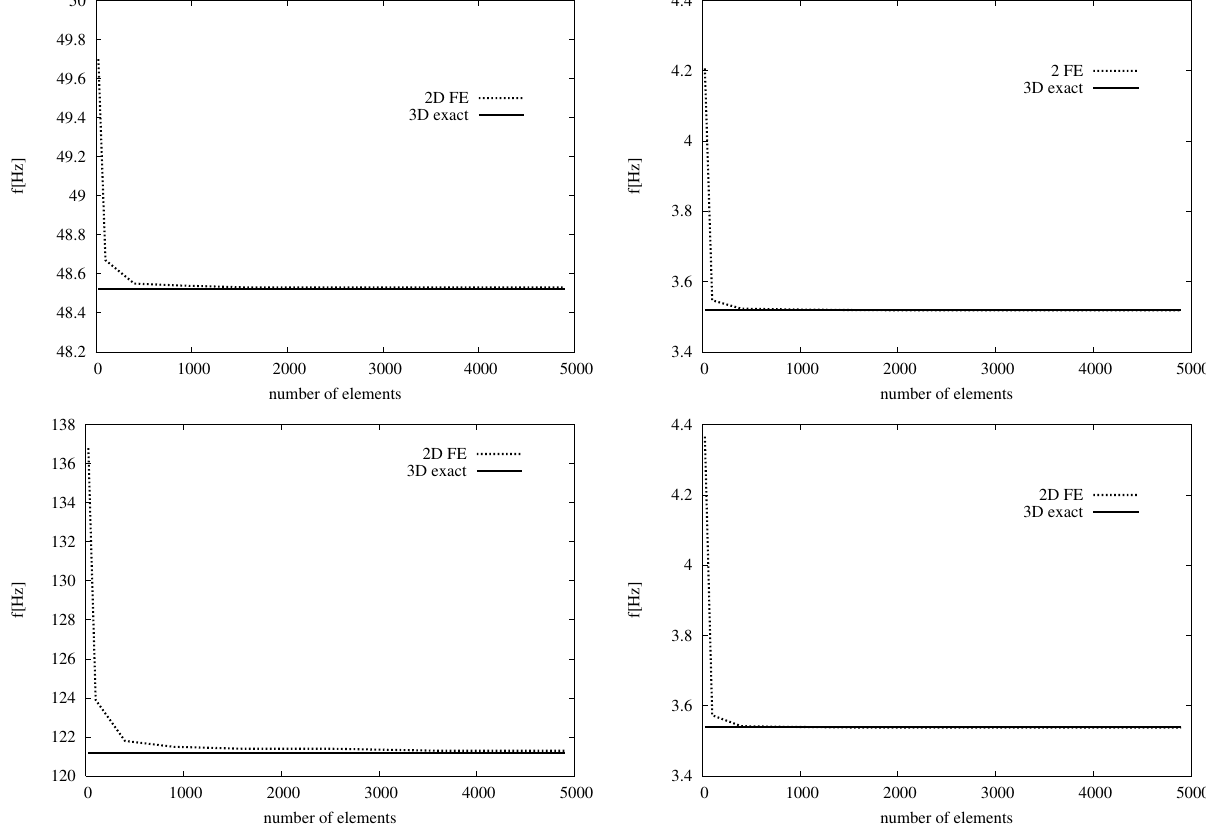
Figure 6: Second assessment for the 2D FE solution, simply sup- ported multilayered cylinder made of aluminium alloy and titanium alloy with thickness ratio R α /h=1000. Frequency f[Hz] vs. number of elements for the mode (18,1) (at the top) and for the mode (20,1) (at the